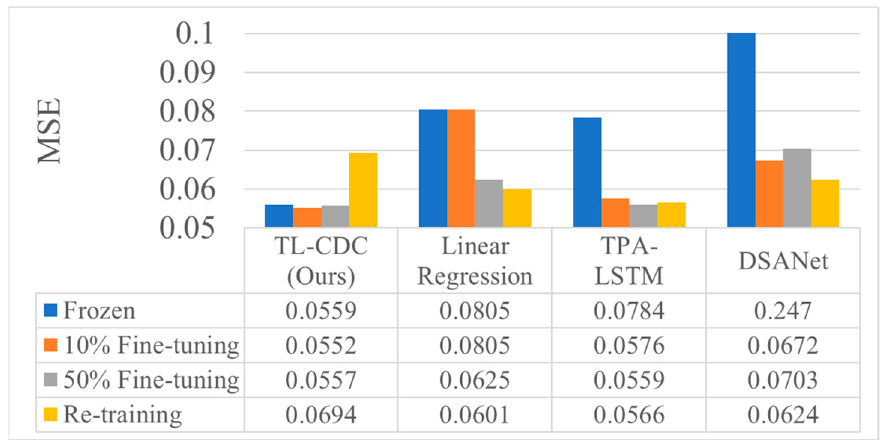
Figure 18. Comparison of TL-CDC and other time series models for predicting the course develop- ment of target disease under k = 2.